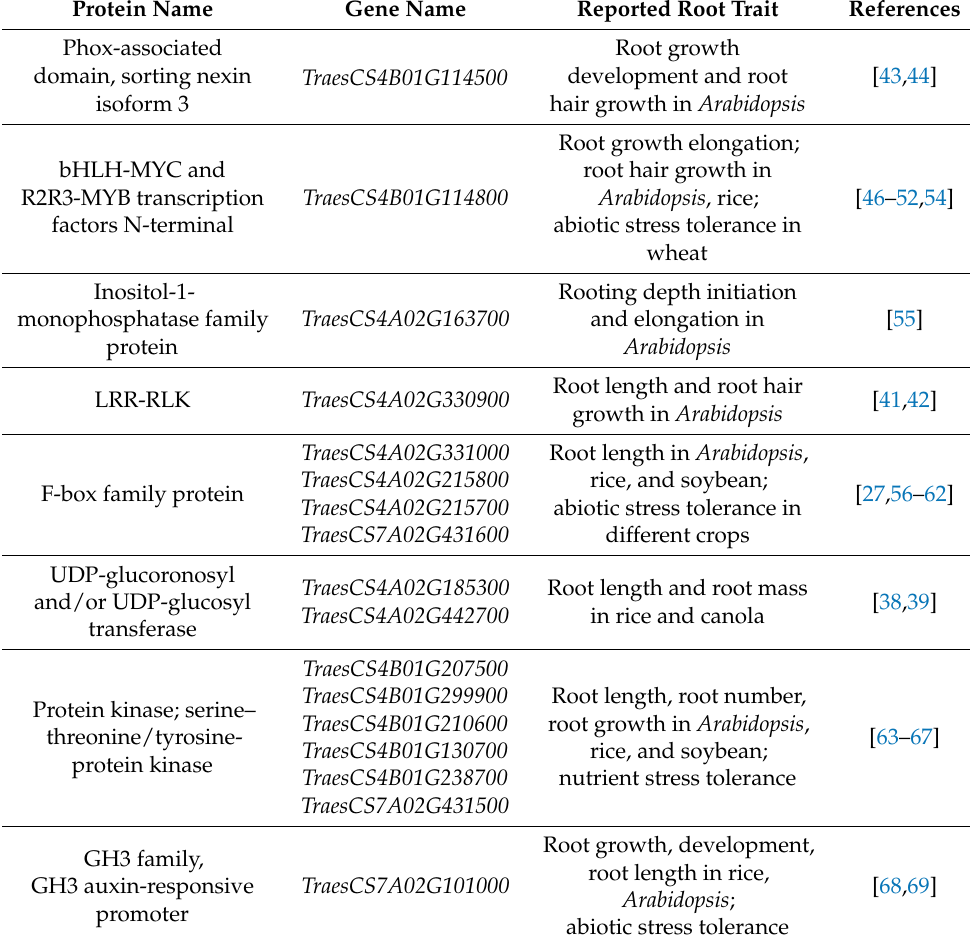
Table 4. Proteins and genes identified as responsible for root traits in crops and Arabidopsis